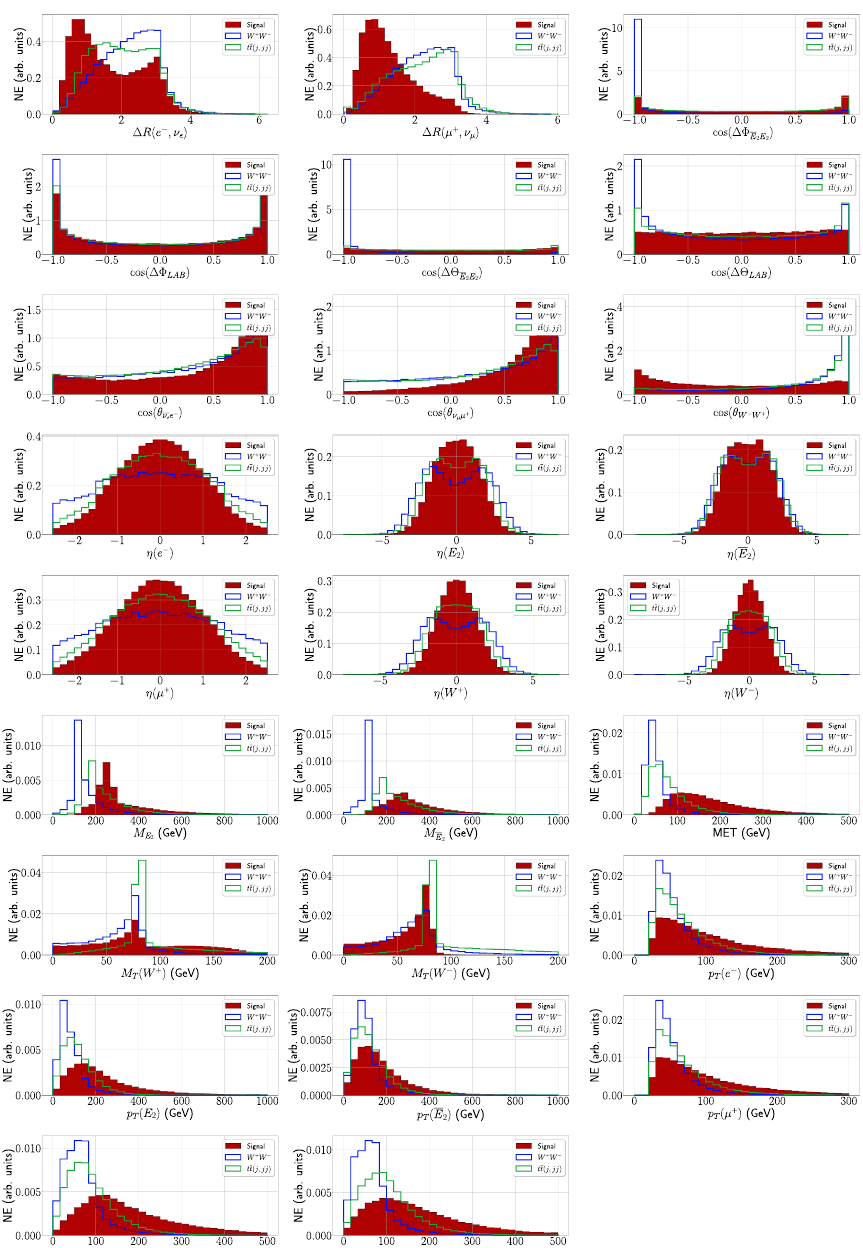
Figure 11. Set of angular and kinematic observables for VLL pair-production via the VBF topology with a mass m E = 200 GeV. All histograms are normalized, with each having 30 bins. Signal 2 distributions are filled and shown in red, while background distributions are unfilled and shown in blue ( W + W − ) and green ( t ¯ t + ( j, jj ) ). From top-left to bottom-right, we have ∆ R distributions for final states combinations ( e − , ν ) and ( µ + , ν ) ; distributions for cosine of angle ∆Φ and ∆Θ in the laboratory and E 2 ¯ E 2 centre-of-mass frames; distributions of the cosine of the angle between the pairs of particles ( ν, e − ) , ν, µ + and W + W − ; pseudo-rapidity for the particles e − , E 2 , ¯ E 2 , µ + , W + and W − ; mass distributions for E 2 and ¯ E 2 ; MET; transverse mass distributions for W + and W − and transverse momentum distributions for e − , E 2 , ¯ E 2 , µ + , W + and W −